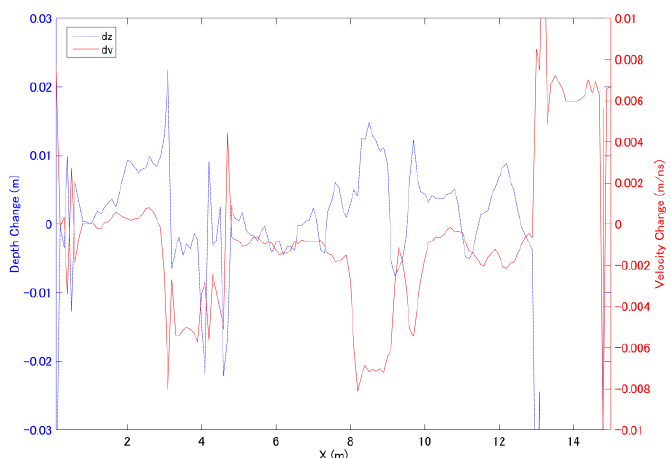
Figure 9. Simultaneous estimations of the velocity and thickness deviations along the survey line. The reference CMP dataset was obtained at x = 0.5 m.